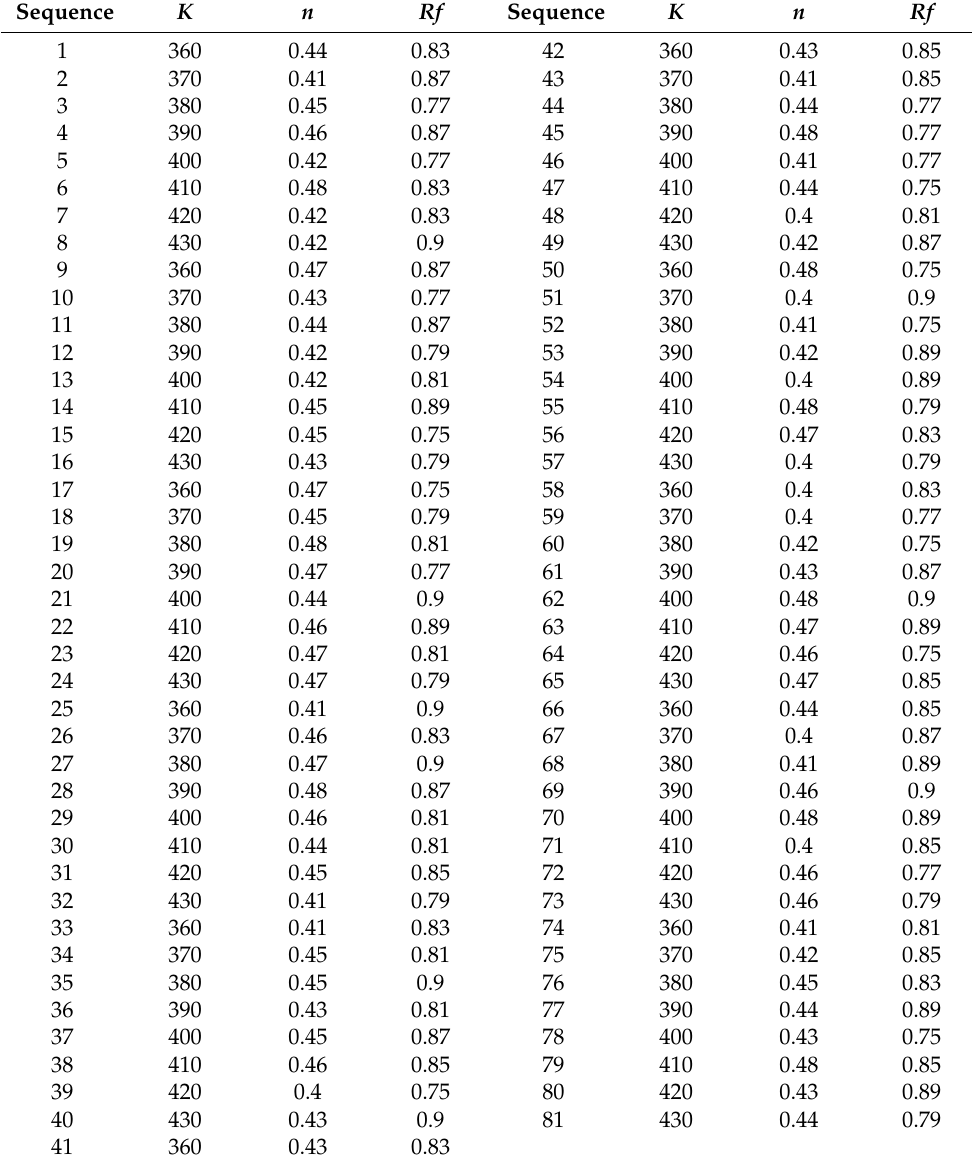
Table 2. Combinations of material parameters.